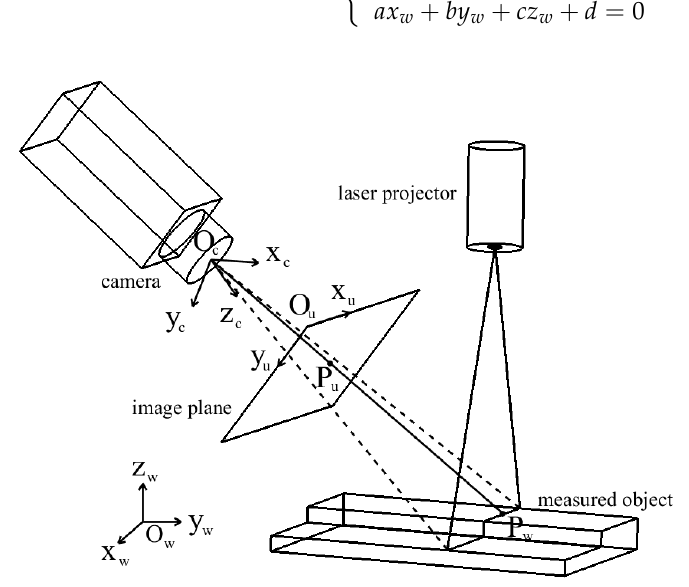
Figure 2. Schematic of the line-structured light vision sensor.